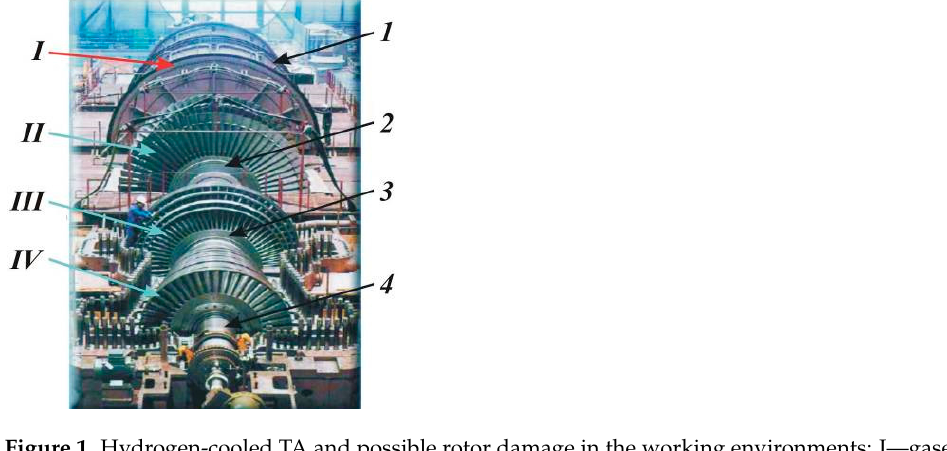
Figure 1. Hydrogen-cooled TA and possible rotor damage in the working environments: I—gaseous hydrogen (0.5 MPa MPa, 80 °C), II, III, IV—steam (0.25 … 5 MPa, 190 … 540 °C), rotors of TG (1), low (2), intermediate (3), high (4) steam turbine pressure [2,6].